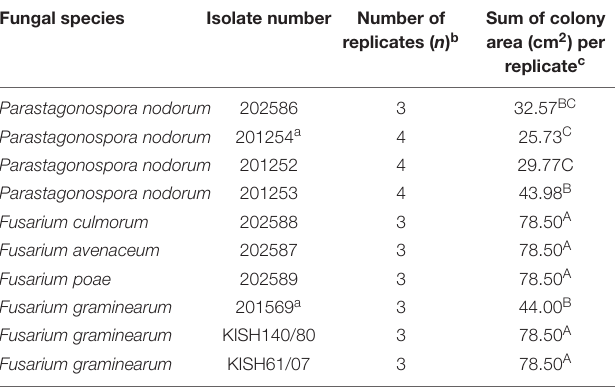
TABLE 1 | Number of replications and average sum of colony area with standard error for each fungal isolate grown on four 5-cm Petri plates at time of volatile organic compound collection (6–10 days after